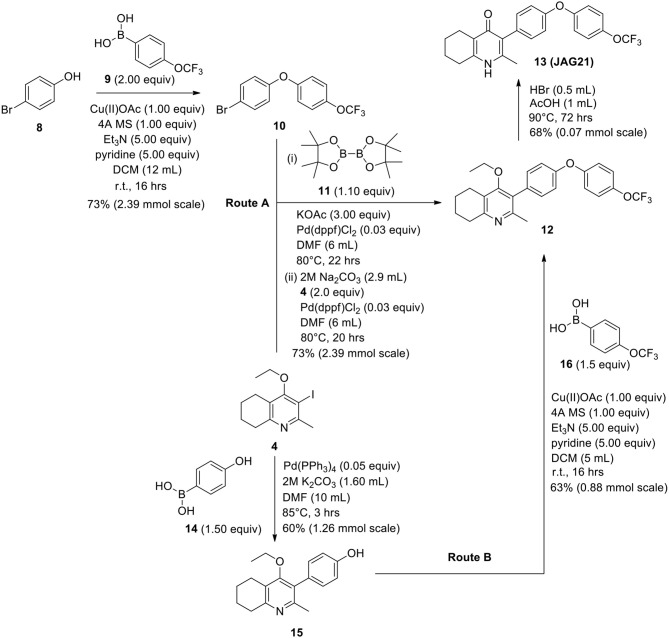
Synthetic route to analogs of 7 (MJM170) via route A or route B. Route A is the original route to analogs but is linear and involves a tricky Suzuki step to intermediate 12 from intermediates 4 and 10. Route B allows quicker access to analogs since intermediate 15 can be made in larger quantities and derivatives can be synthesized via the Chan-Lam reaction to give final intermediate 12 by varying the boronic acid 16.